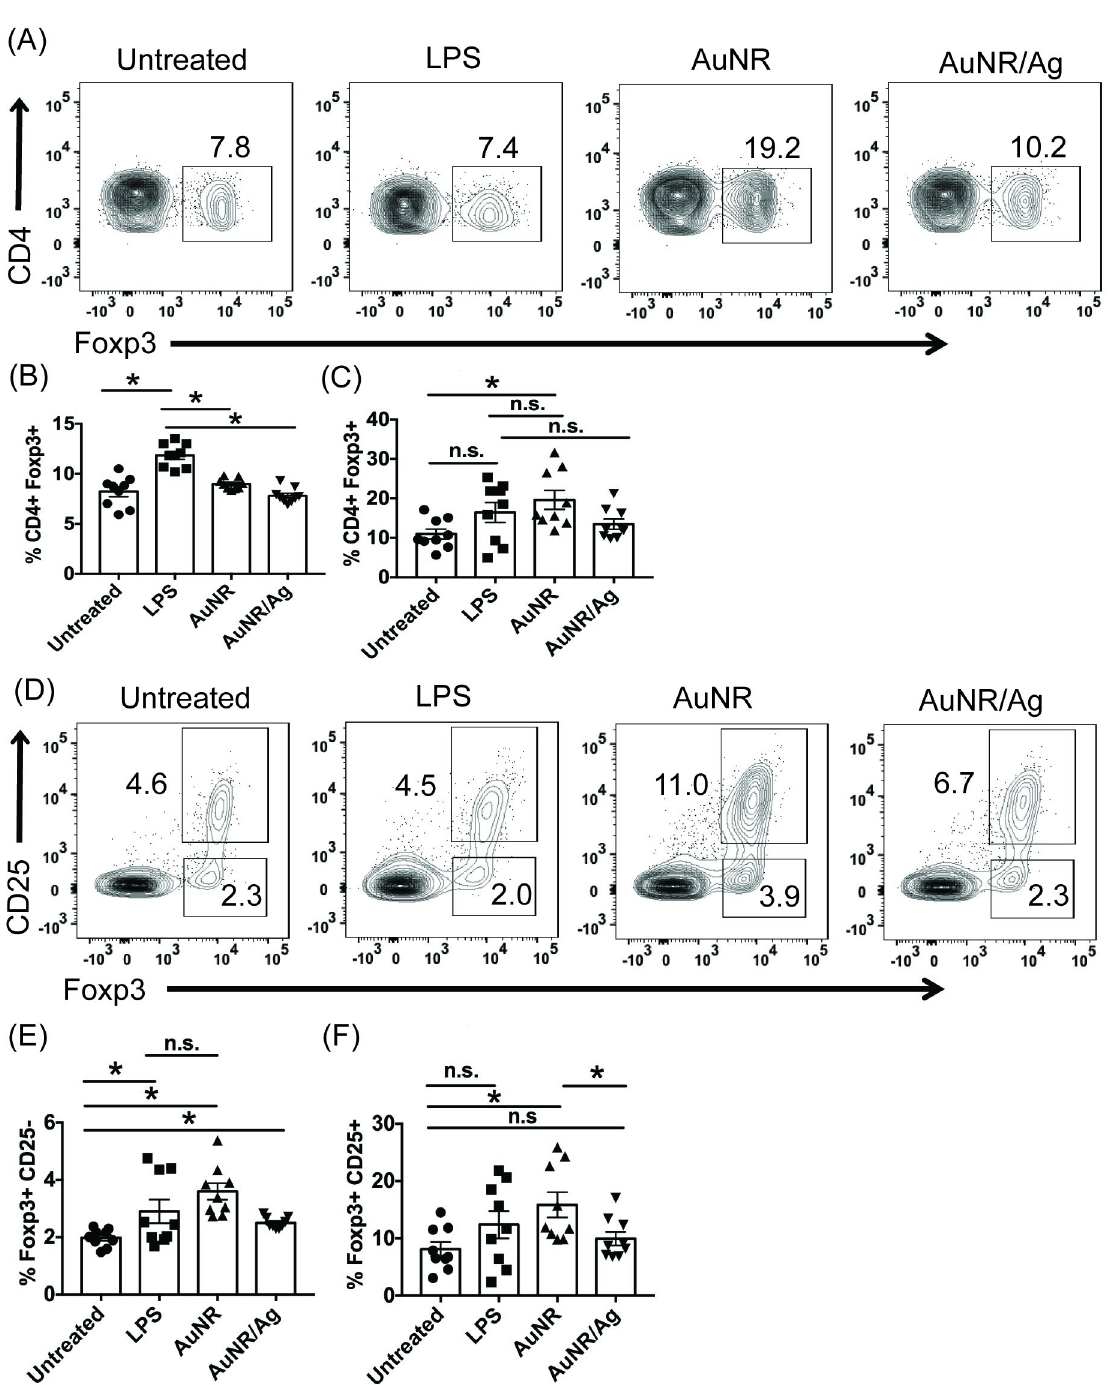
Fig 3. AuNR and AuNR/Ag have different impacts on CD4+ Foxp3+ Tregs. Splenocytes were either untreated or treated with 100 μ g/ml AuNR, 100 μ g/ml AuNR/Ag, or 5 μ g/ml LPS, and flow cytometry was performed after 24 hours (B) and (E) or after 72 hours: (A), (C), (D), and (F) . The flow data are gated on the percent live, and the experiments are a compilation of 3 independent experiments; n = 9 per group. The data is represented as scatter dot plots, where error bars represent the standard error of the mean and � p � 0.05 is significant as determined by a two-sided t